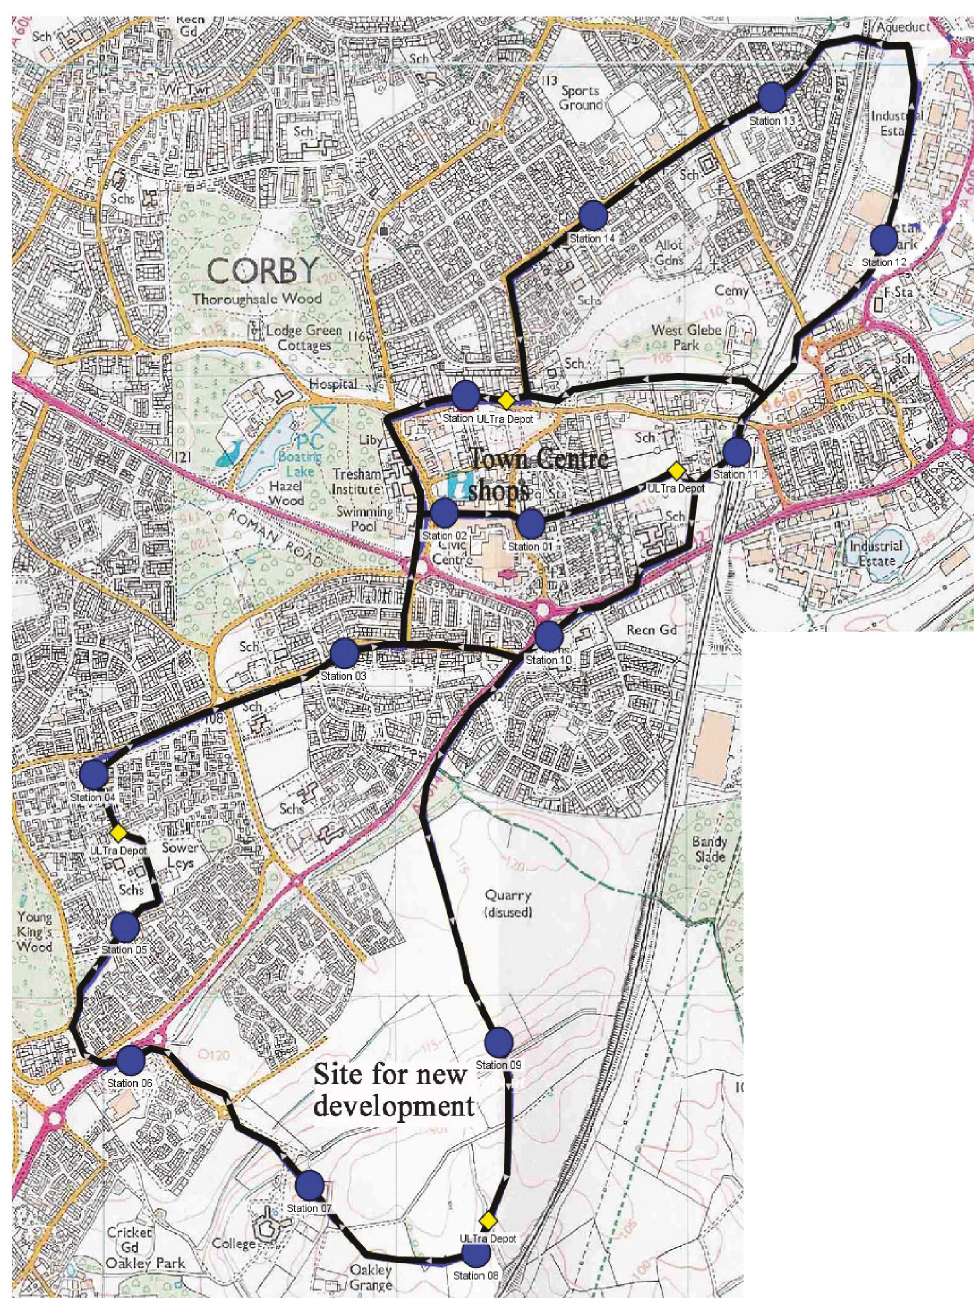
Figure 4: The Corby